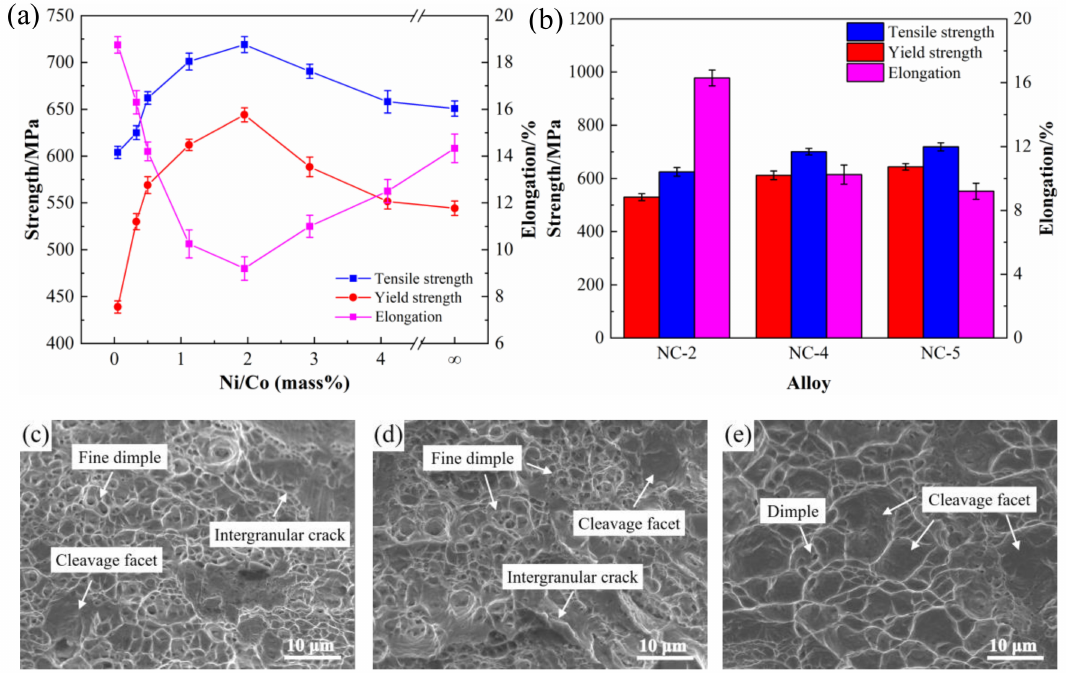
Figure 3. ( a ) The tensile properties of alloys aged at 500 ◦ C for 1 h with di ff erent Ni / Co ratios; ( b ) comparison of the tensile properties of the three alloys under peak aging conditions; the corresponding fracture morphologies of the ( c ) NC-2, ( d ) NC-4, and ( e ) NC-5